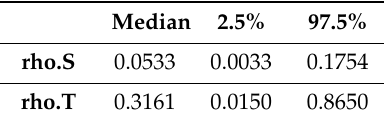
Table 1. The posterior median and 95% credible interval for the spatial and temporal dependence parameters on the urban heat island (UHI).